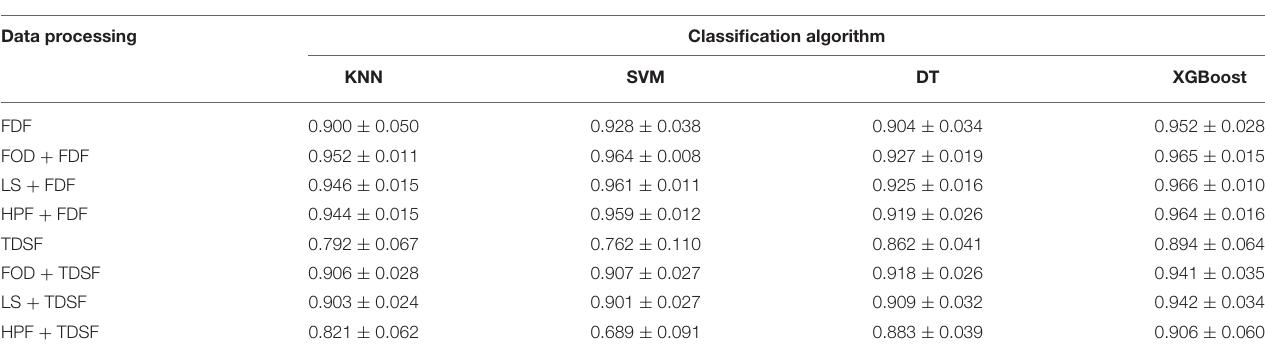
TABLE 5 | The experiment with multi-machine learning (ML)